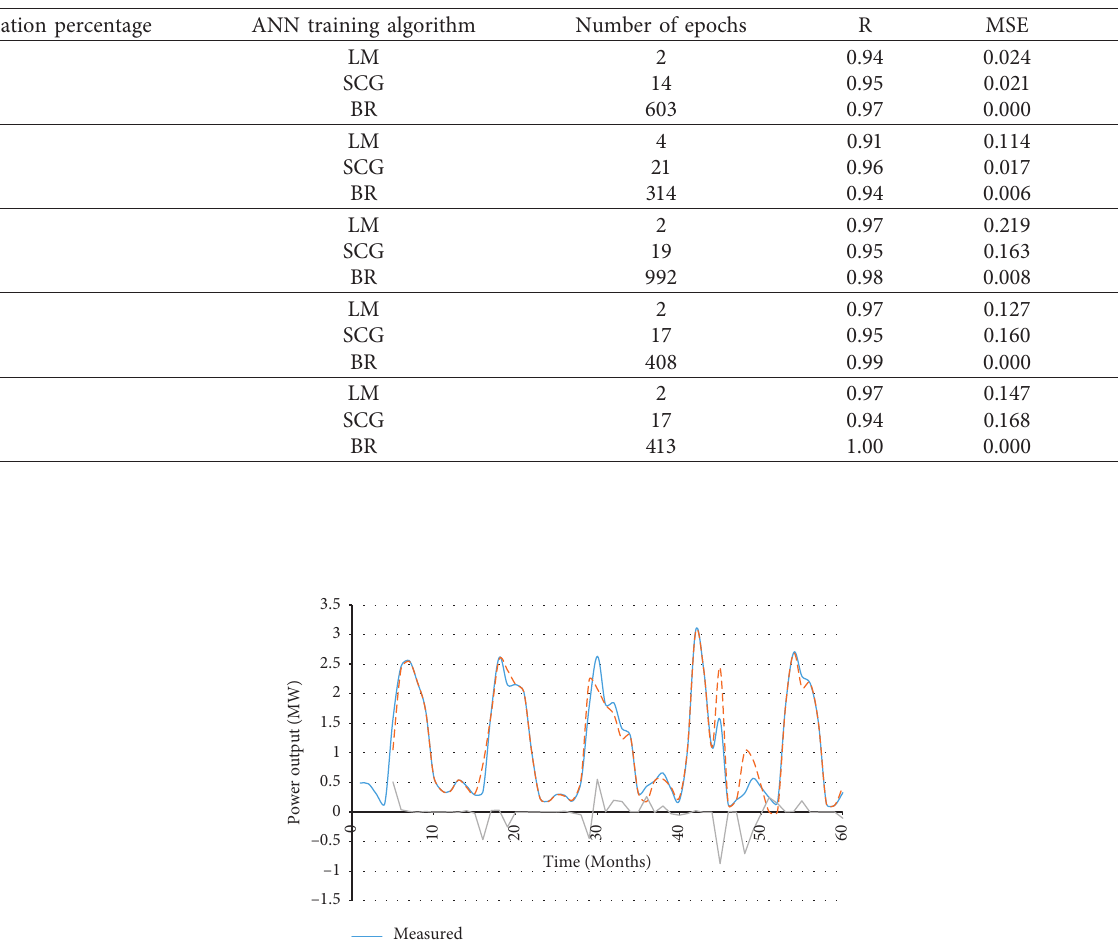
Table 1: Performance of the algorithms for different validation percentages.